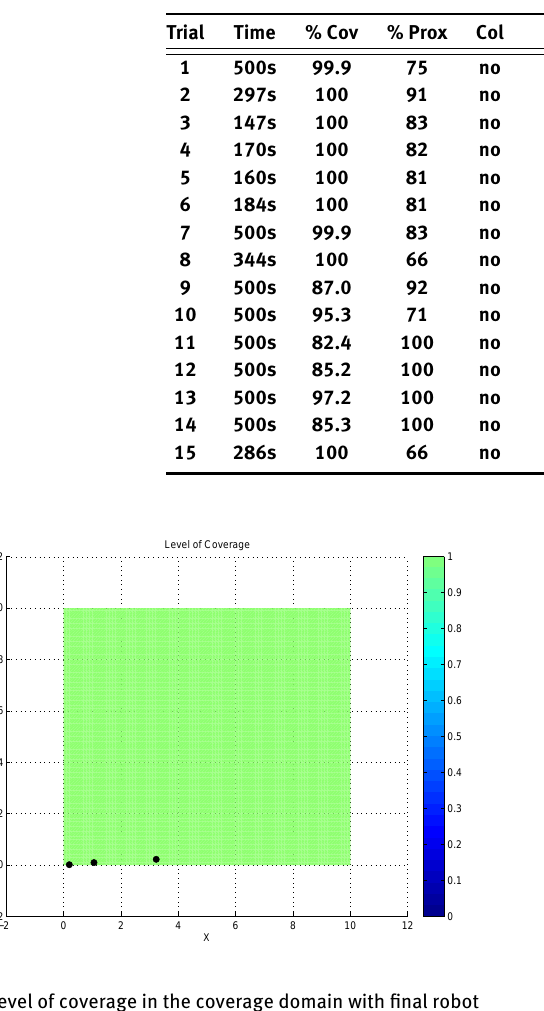
Fig. 6. Level of coverage in the coverage domain with final robot locations.